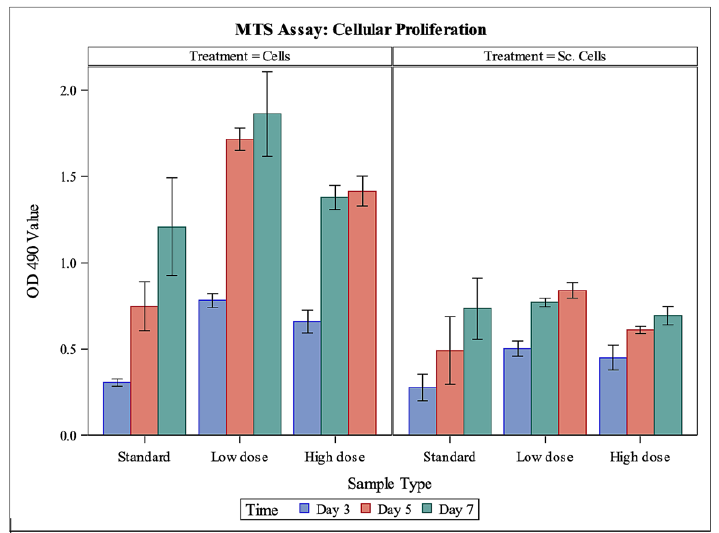
Figure 2. MTS assay to measure cellular proliferation. Left-side panel (cells) demonstrates mean cellular proliferation, measured through absorbance, of MC3T3-E1 cells in cell culture exposed to standard media, or a low or high dose of gentamicin, through time. Right-side panel (Sc. Cells) demonstrates mean cellular proliferation, measured through absorbance, of MC3T3-E1 cells on Fi- bro-Gide ® wafers exposed to standard media, or a low or high dose of gentamicin, through time. Cells in cell culture had a significantly higher proliferation than cells on collagen matrix ( p < 0.0001). Sc. Cells, cells on Fibro-Gide ® wafers.